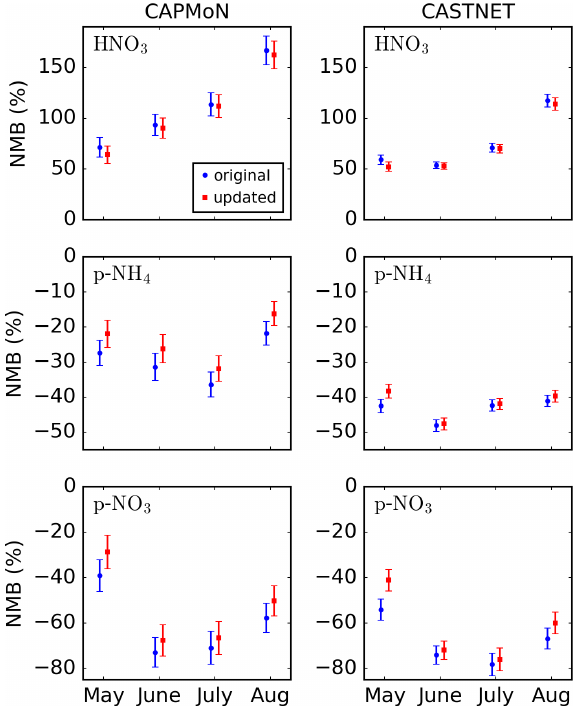
Figure 11. Normalized mean biases between GEM-MACH HNO 3 , p-NH 4 , and p-NO 3 surface fields and observations from the CAP- MoN and CASTNET networks for May to August 2016. In the leg- end, “original” and “updated” indicate the ammonia emissions used in GEM-MACH. Error bars correspond to the standard